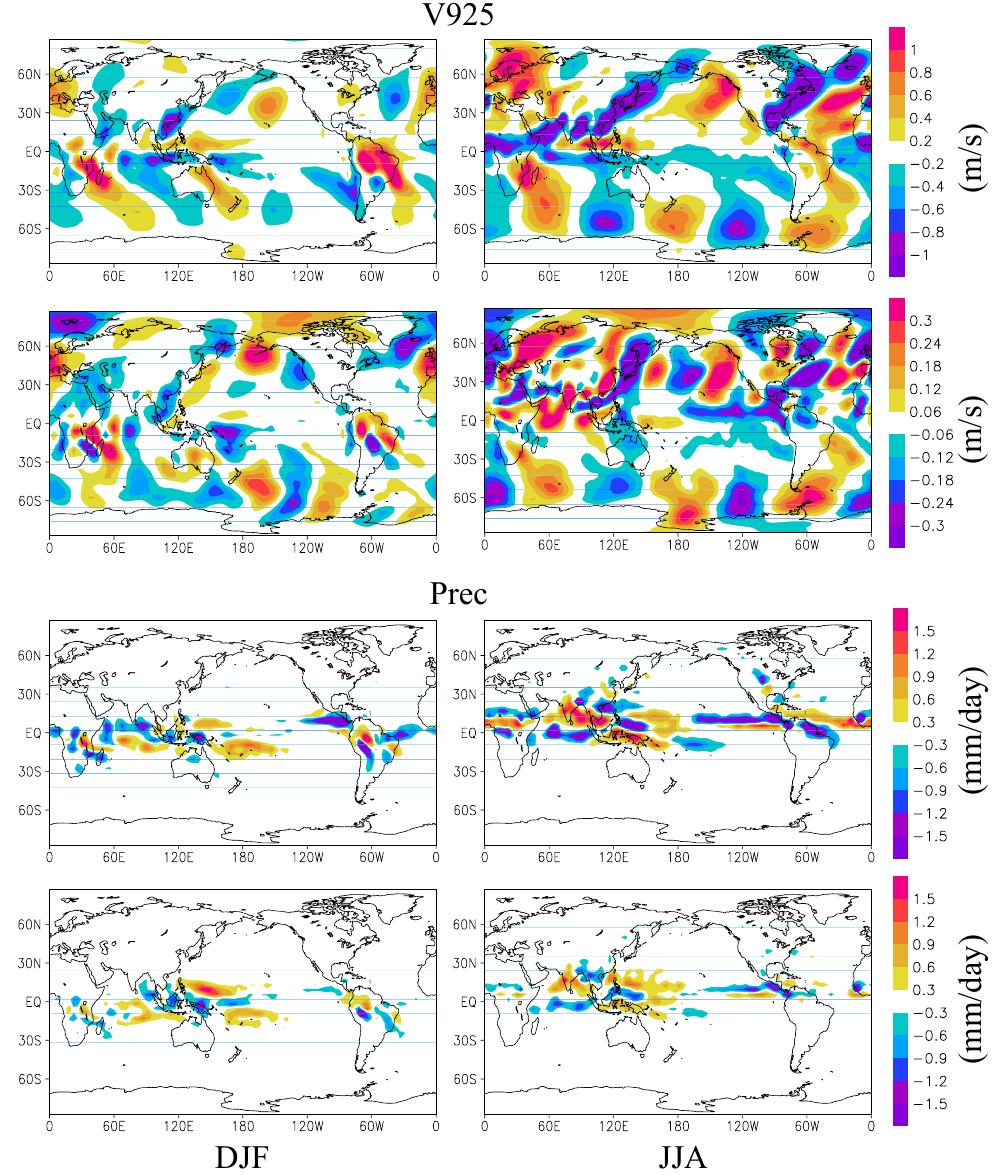
Fig. 5. Ensemble-mean measures of the sensitivity of the modeled error for meridional wind at 925hPa in Cl Alb (top two panels) and precipitation in RH Conv (bottom two panels), in boreal winter (December–February) and summer (June–August). The linear contributions a i are shown in the first and third pair of panels multiplied by µ i to give units of ms − 1 and mmday − 1 respectively, for the values that would Max occur at the positive end of the feasible range of Cl Alb and RH Conv . The quadratic contributions b ii , similarly given as b ii µ 2 in ms − 1 and i Max mmday − 1 , are shown in the second and bottom pairs of panels. The two contributions added together represent the total difference between µ i and the standard case. Here the subscript i denotes Cl Alb for the wind maps and RH Conv for Max